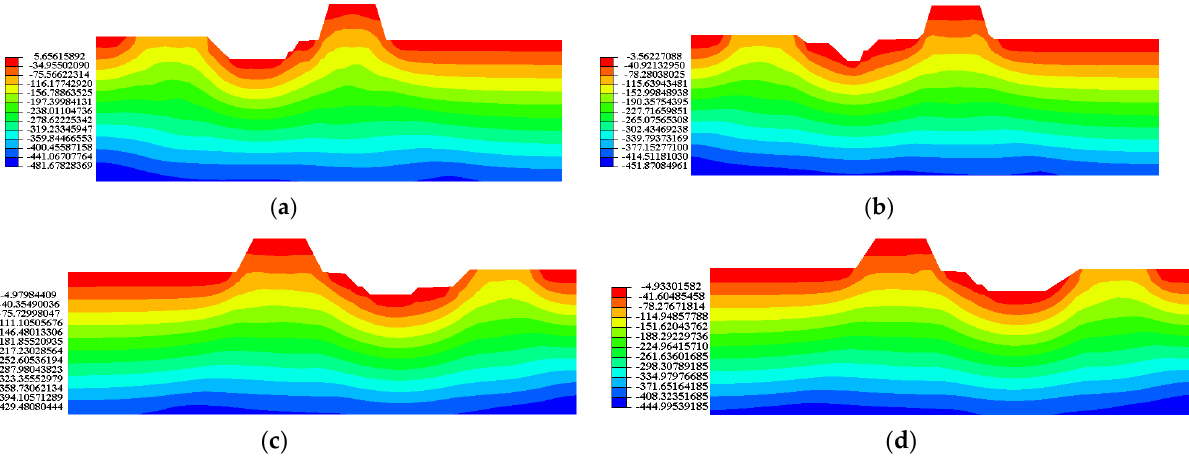
Figure 10. Diagram of the simulation results of longitudinal stress of dangerous sections under condition 1. ( a ) section B − B; ( b ) section E − E; ( c ) section H − H; ( d ) section J − J. (The unit in the legend is N).